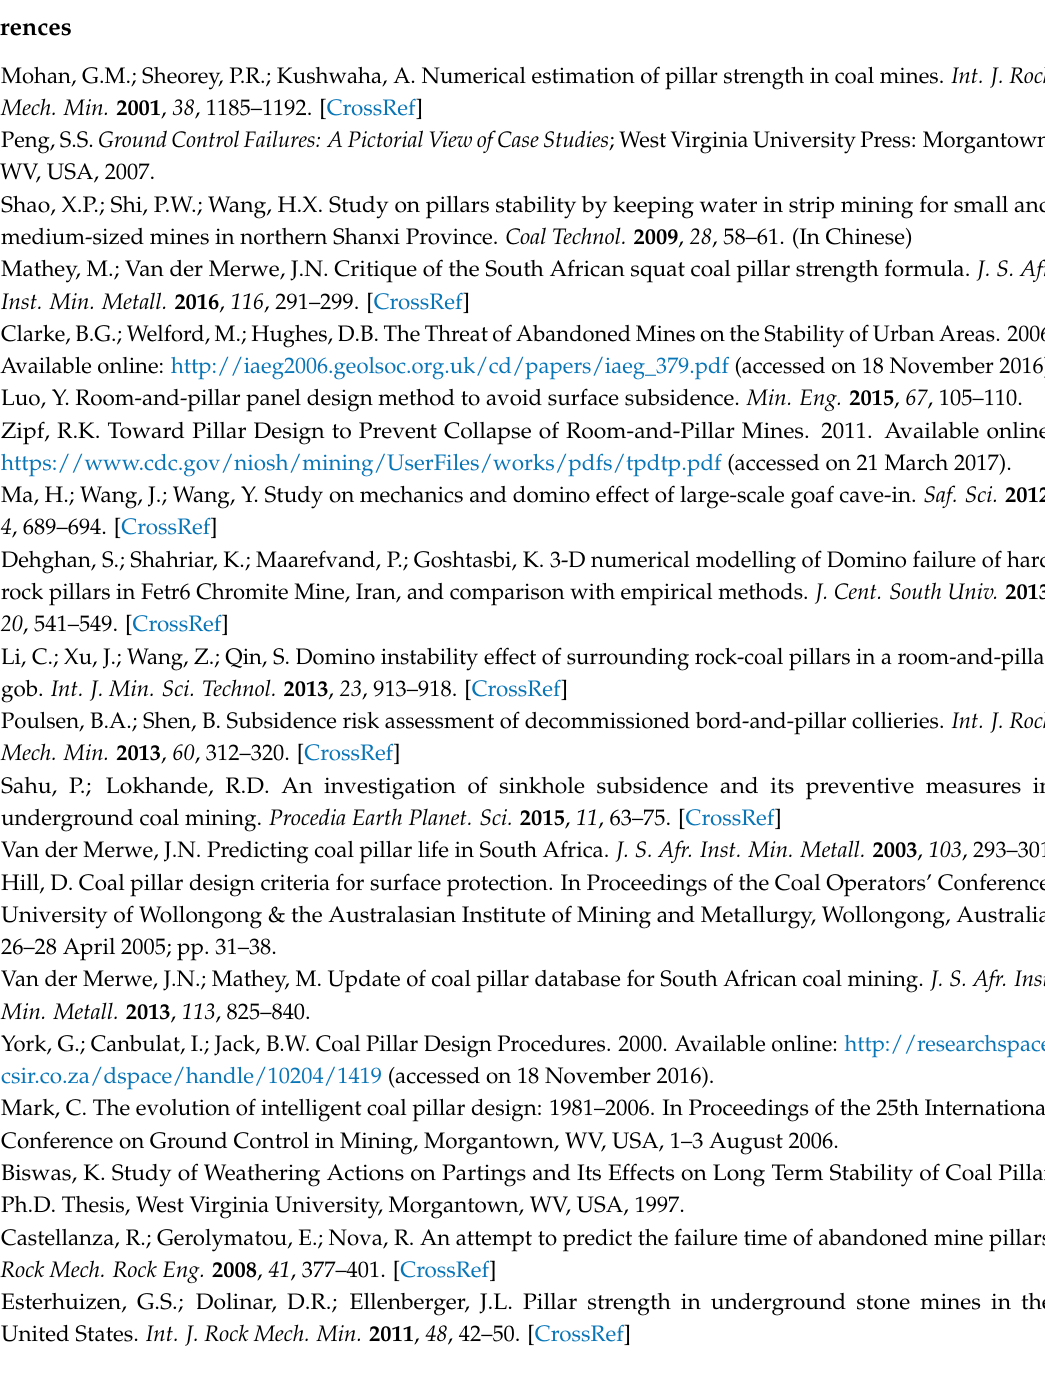
Table S4: The stable pillar cases in ordinary coal fields of South Africa, Table S5: The stable pillar cases in Vaal Basin, Free State and Klip river coal fields of South